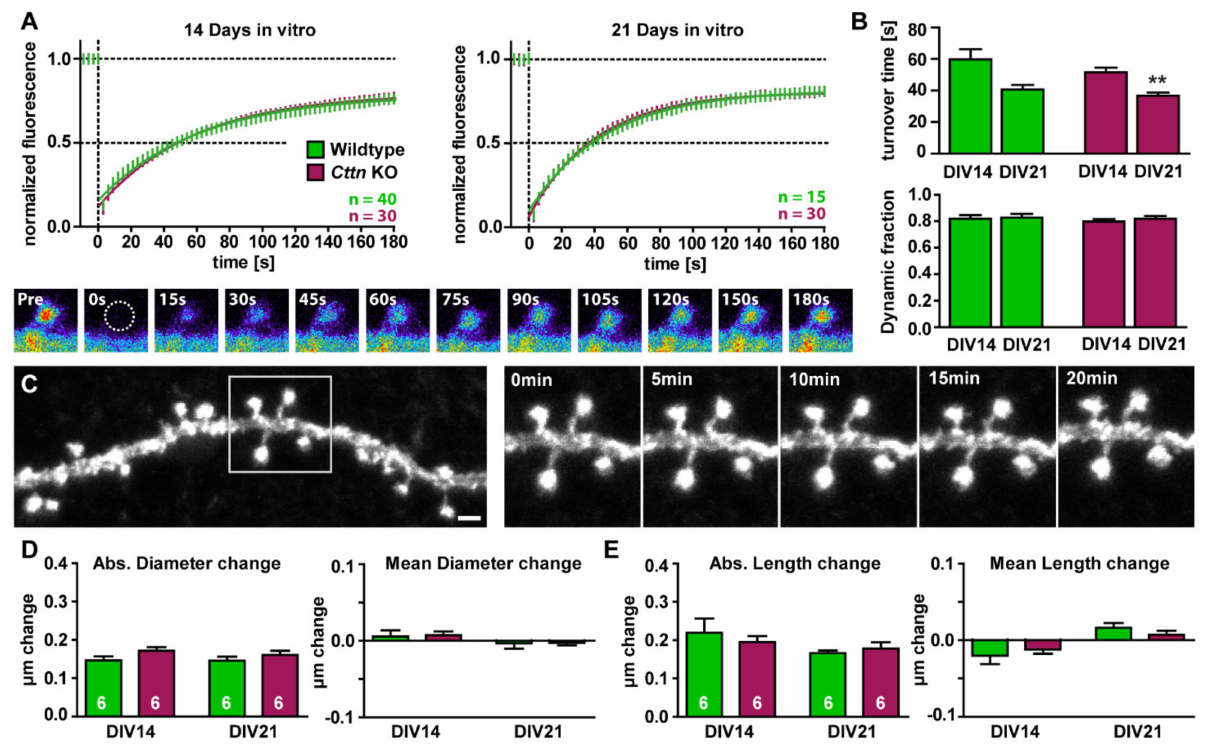
Figure 3. Basal actin dynamics and dendritic spine motility are normal in Cttn-deficient hippocampal neurons. ( A ) Basal actin dynamics as analyzed via fluorescence recovery after photobleaching (FRAP) of EGFP-ß-actin in primary dissociated hippocampal neurons after 14 as well as 21 days in culture. Depicted are the recovery curves of hippocampal WT and Cttn -KO spines under baseline conditions. Representative images show fluorescence levels derived from EGFP-ß-actin of an individual dendritic spine before bleaching as well as during recovery of fluorescence over a time course of 180 s after the bleaching pulse. n = number of dendritic spines analyzed. ( B ) Quantification of the turnover time and the fraction of dynamic actin (the amount of actin fluorescence which recovered in the time period of 180 s after the photobleach). ( C ) Analysis of dendritic spine motility. Representative images depict an individual dendritic stretch that was repeatedly imaged every 5 min for a total of 20 min. Scale bar = 1 µ m. ( D , E ) Absolute as well as mean changes in ( D ) the head diameter and the ( E ) length of individual dendritic spines in 14- or 21-day-old primary dissociated hippocampal cultures from WT and Cttn -KO mice. n = number of dendrites analyzed. Data information: Statistic tests used: For normal distribution of data: Kolmogorov-Smirnov Test, Parametric Tests: Two-Way ANOVA and Sidak’s Multiple Comparisons, Non-Parametric Tests: Kruskal-Wallis Test and Dunn’s test; data depicted as means ± SEM, detailed information on p values as well as statistical tests is depicted in Table S1; significances are indicated by ** p value <